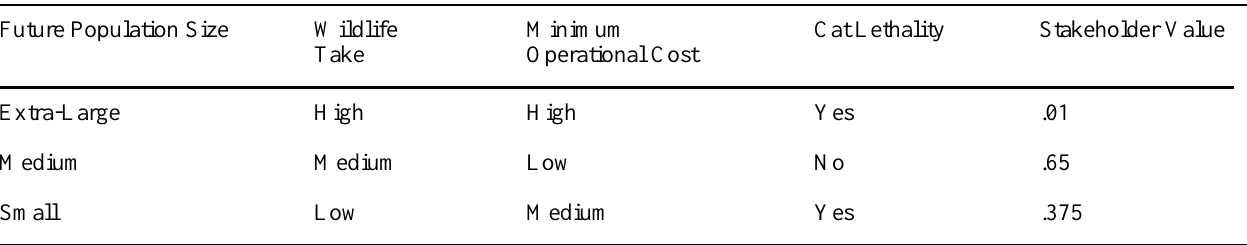
Table 5 . Example of influences and the resulting utility values. This is an average of the values that the Wildlife Conservation and Cat Advocacy representative assigned to each